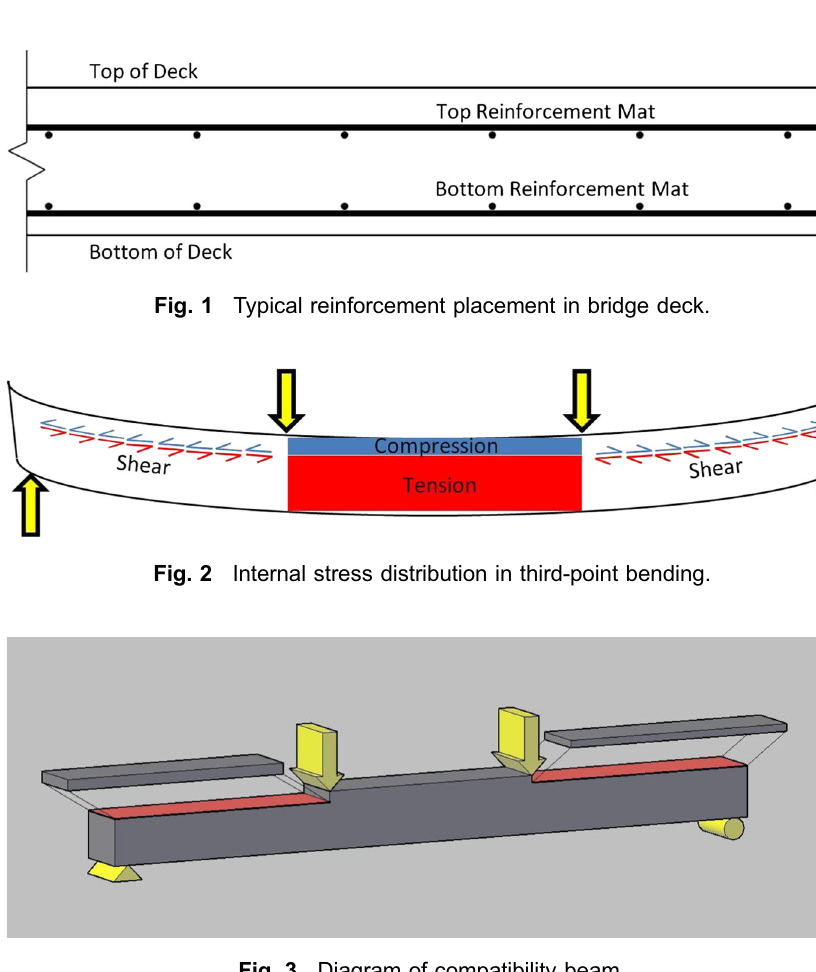
Fig. 3 Diagram of compatibility